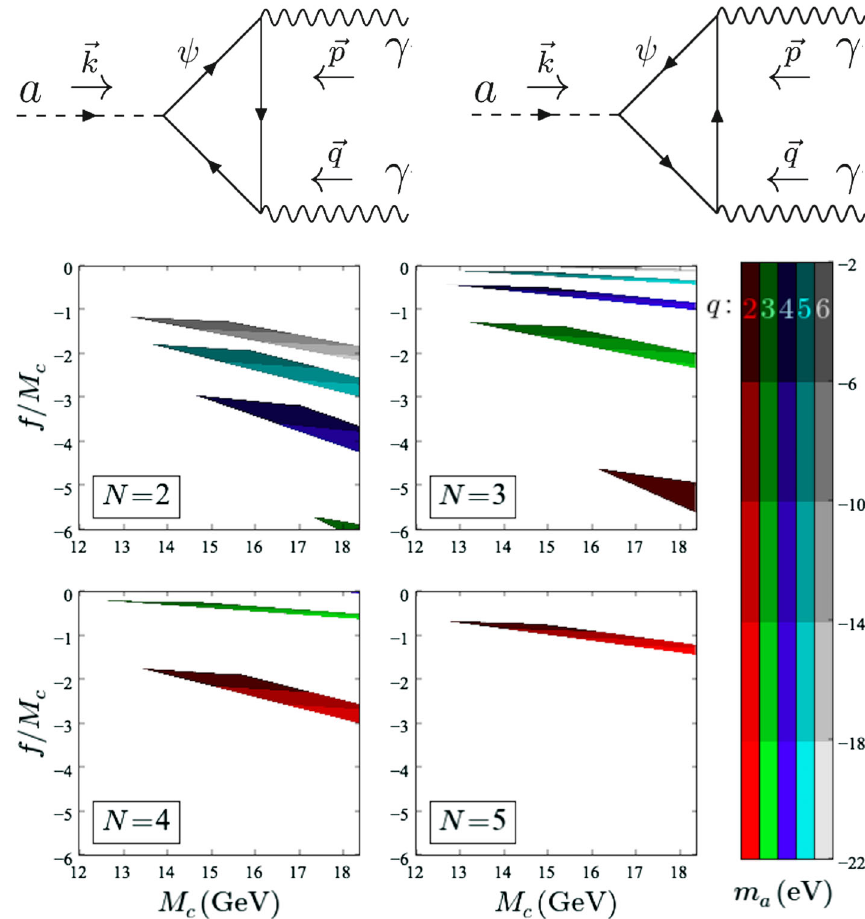
Fig. 6 Feynman diagrams leading to the axion–vector–vector couplings